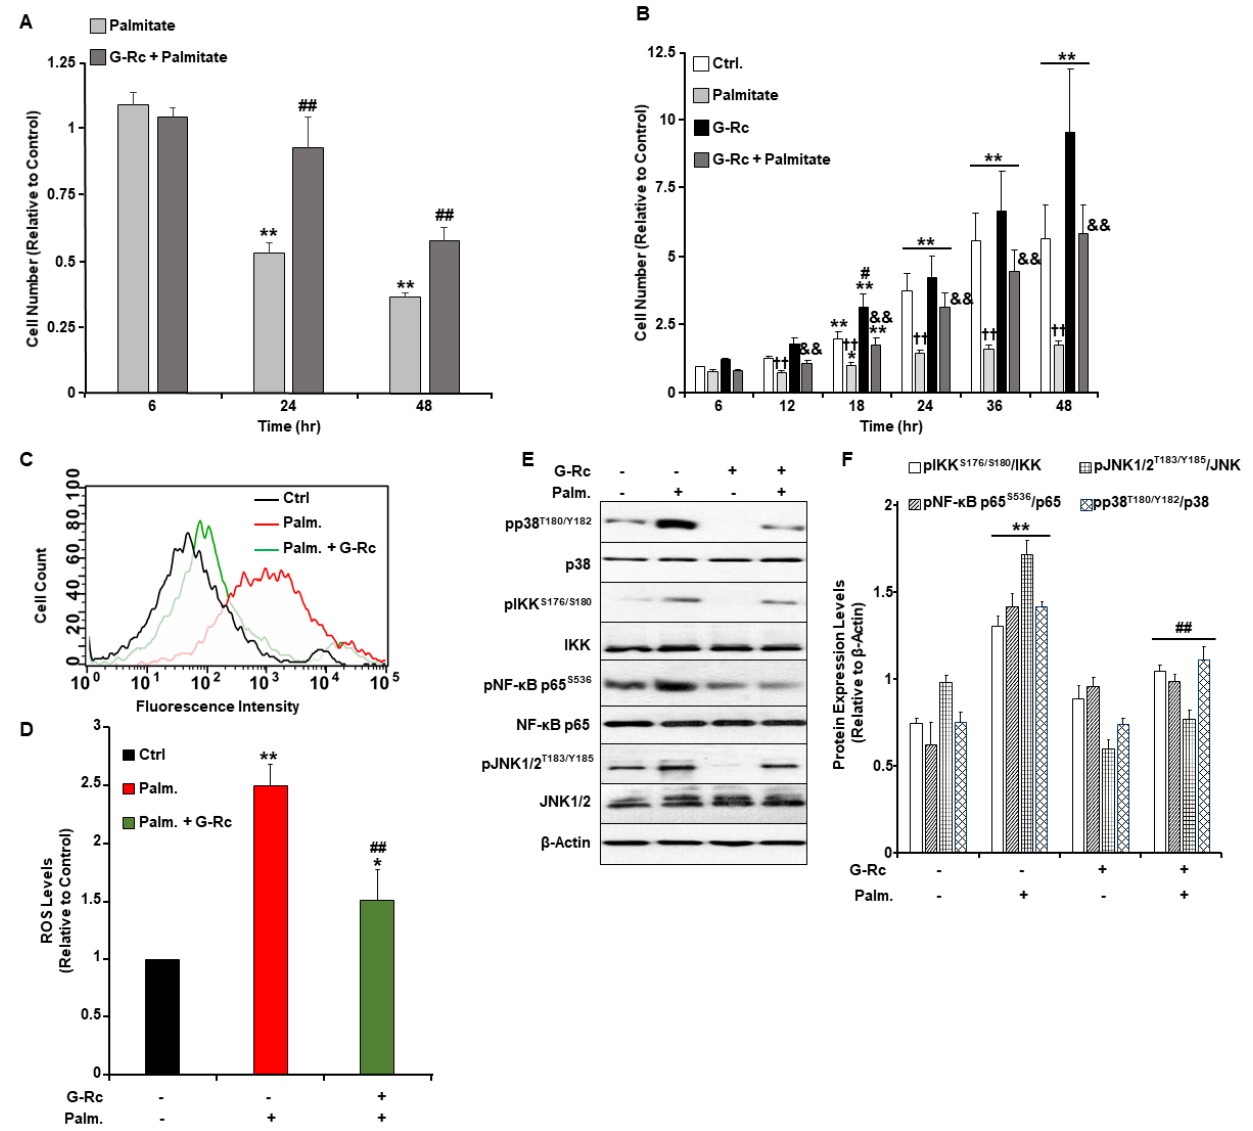
Figure 4. A physiologically relevant dose of G-Rc alleviates palmitate-induced alterations to cell survival and proliferation, oxidative stress, and inflammation. ( A ) Cell toxicity assay using the MTT method in differentiated UB/OC-2 cells treated with a freshly prepared solution of palmitate alone (0.5 mM) or in combination with G-Rc (25 µ g/L) for up to 48 h. Bar graphs represent the intensity of formazan staining reflective of the cell number and are presented as means + SEM. ** p < 0.01 indicates a significant difference between palmitate and non-palmitate-treated cells. ## p < 0.01 indicates a significant difference between palmitate/G-Rc-treated cells and cells treated with palmitate alone. ( B ) Effects of G-Rc on palmitate-induced cell proliferation using the SRB method. Cells were treated with palmitate alone, (0.5 mM), G-Rc (25 µ g/L) alone, or a combination of palmitate and G-Rc for up to 48 h. Bar graphs represent the intensity of SRB staining reflective of the cell number and are presented as means + SEM. * p < 0.05 and ** p < 0.01 indicate a significant difference between the indicated time and control cells at 6 h post-seeding. # p < 0.05 indicates a significant difference between G-Rc-treated cells (non-palmitate-treated) and control cells non-treated with G-Rc nor palmitate. †† p < 0.01 indicates a significant difference between cells treated with palmitate alone versus control cells non-treated with palmitate nor G-Rc. && p < 0.01 indicates a significant difference between cells treated with a combination of palmitate and G-Rc versus cells treated with palmitate alone. ( C , D ) Flow cytometry assessment of ROS production as determined using CM- DCH 2